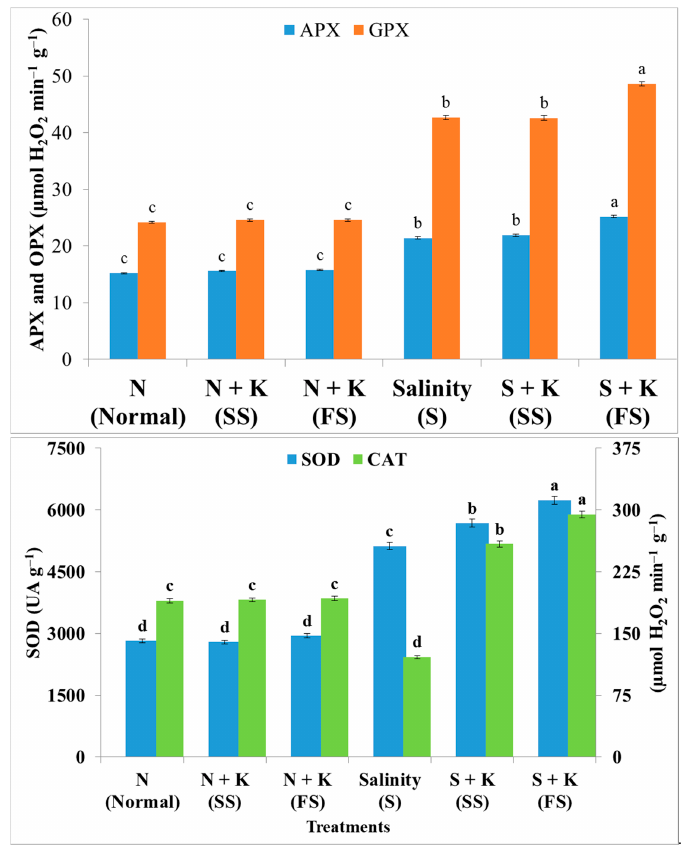
Figure 6. Effect of seed soaking (SS) and foliar spray (FS) of potassium (6 mM K 2 SO 4 ) on leaf activities of superoxide dismutase ascorbate peroxidase (APX), glutathione peroxidase (GPX), superoxide dismutase (SOD) and catalase (CAT) in soybean plants grown under normal (EC = 2.68 dS m − 1 ) and saline (EC = 7.46 dS m − 1 ) conditions. Means followed by the same letter in each parameter are not significantly different according to the LSD test ( p ≤ 0.05). Error bars are ± Standard Error (SE). As shown in Figures 7 and 8, with the exception of limited fluctuation, FS or SS with potassium did not affect soybean yield or its components and quality (pods number plant − 1 , 100-seed weight, yield of seed ha − 1 , protein % and oil %) under normal conditions compared with controls. However, salt-stress treatment markedly reduced these yield parameters compared with the normal control (Figure 7). Compared with the corresponding control, potassium applied by FS or SS significantly increased the pod number plant − 1 , 100-seed weight, yield of seed ha − 1 , protein % and oil % under salt